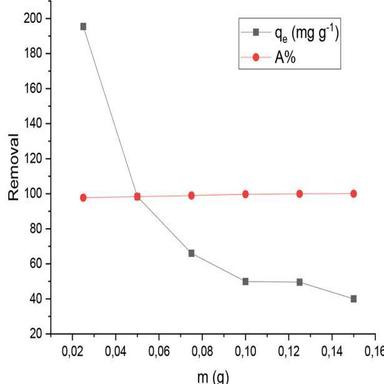
The influence of adsorbent dosage on the adsorption of MB on Perlite@GO.